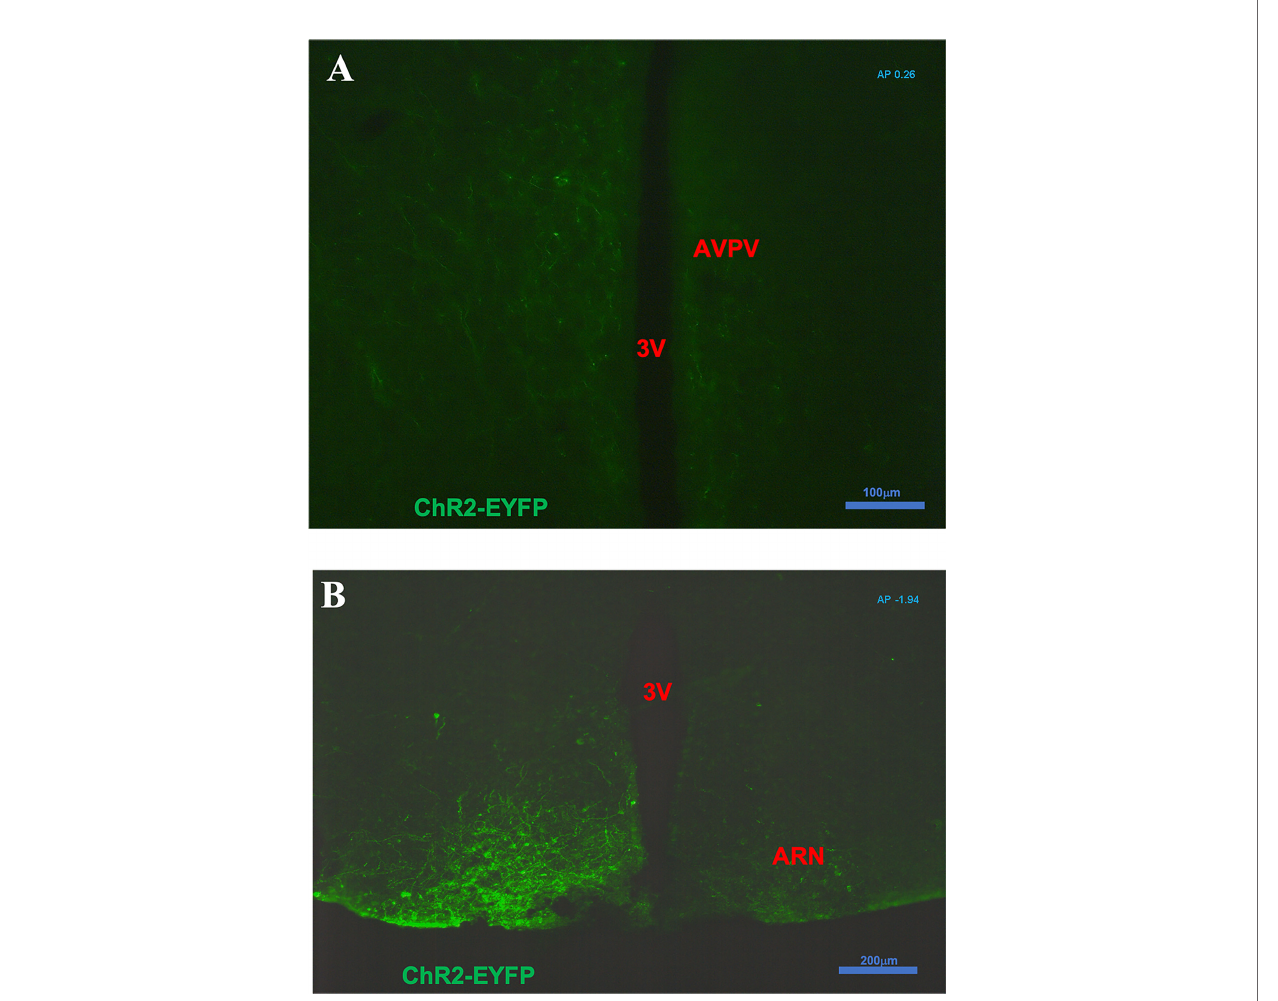
FIGURE 1 | Expression of ChR2-EYFP in kisspeptin neurons in the arcuate nucleus (ARC) and fi bers in the anteroventral periventricular nucleus (AVPV) in Kiss-cre mice. The coronal brain sections were obtained from Kiss-CRE mice to verify the expression of ChR2-EYFP in Kisspeptin neurons. (A) Note a number of ARC Kiss1 projection fi bers showing in the AVPV (AP +0.26 from Bregma); especially obvious on the ipsilateral virus injection side. (B) Note kisspeptin neurons with ChR2-EYFP expression in the virus (pAAV-EF1a-double fl oxed-hChR2(H134R)-EYFP-WPRE-HGHpA) injection side of ARC area (AP -1.94 from